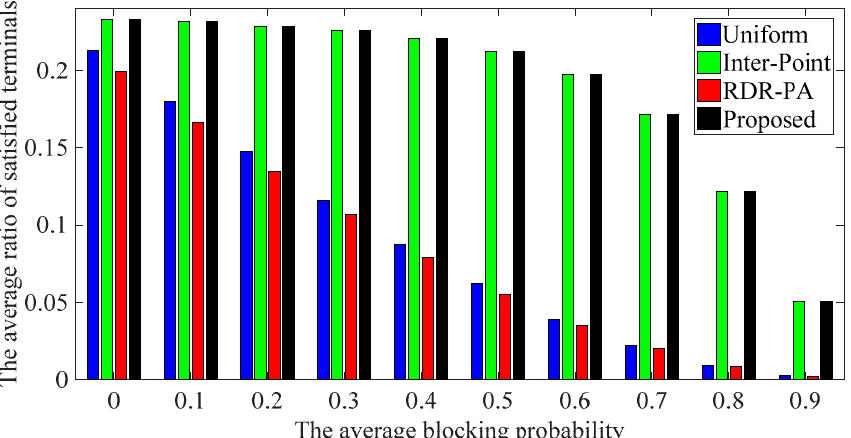
Figure 10. The average ratio of satisfied terminals versus average blocking probability.